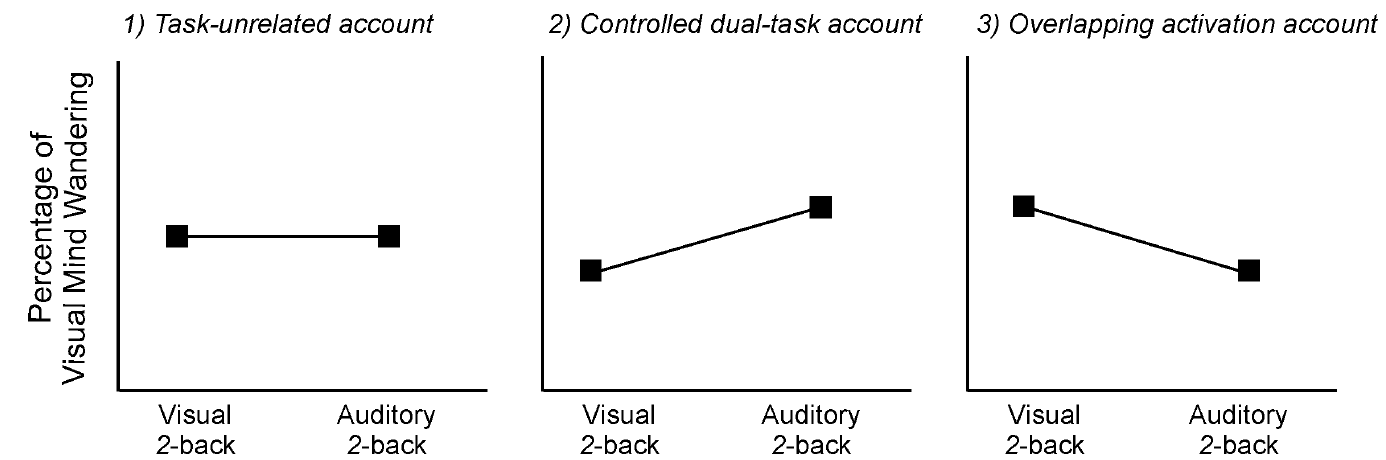
Fig 1. Three possible predicted relations between task modality and form of mind wandering. 1) Mind wanderingis task-unrelated, 2) mind wandering is greater in a modality different from the task modality, and 3) mind wandering is greater in the task modality.